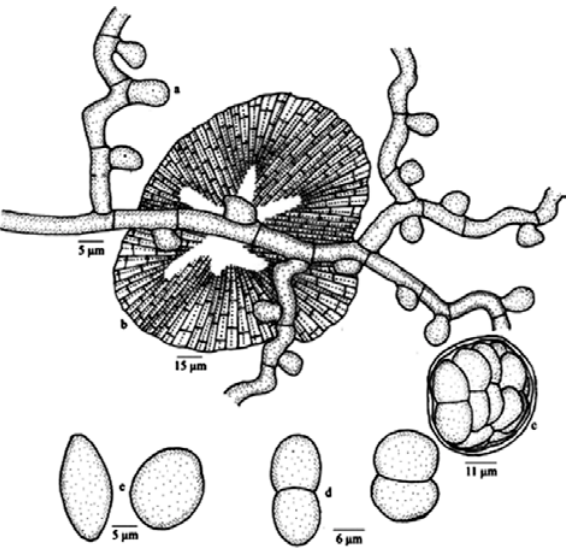
Figure 139. Asterina deightonii a - Appressorium; b - Thyriothecium; c - Ascus; d. Ascospores, e -